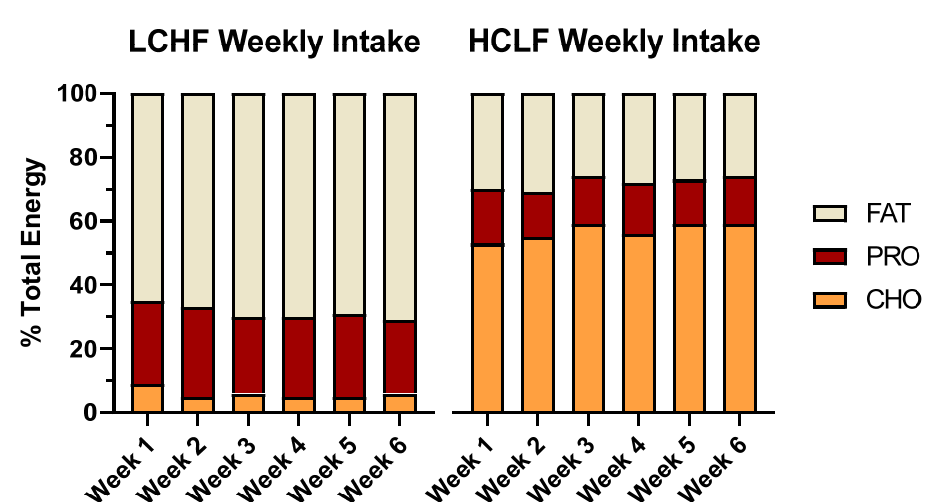
Figure 3. Mean participant energy intake and macronutrient distribution. The 3-day dietary records collected from all participants ( n = 7) are presented as a weekly average of percent energy distribution from dietary fat, protein, and carbohydrates. A one-way ANOVA between diet conditions revealed significant differences across all relative macronutrient categories ( p < 0.001), but no significant differences in total energy intake ( p > 0.05).